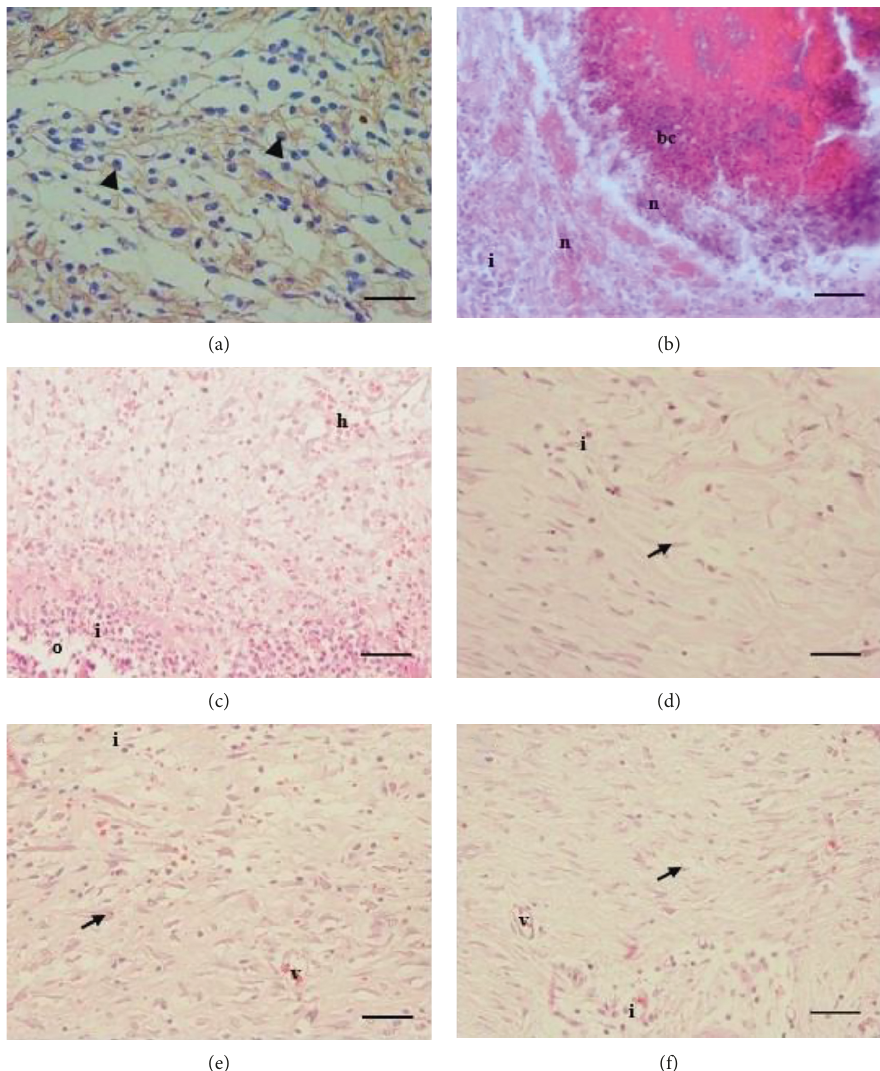
Figure 2: Photomicrographs of the dermal part of the skin wound healing. Predominantly expression of CD8+ on day 5 in treatment group (a); skin wound of control group on day 5 showed severe necrosis with bacterial colonization (b); dermis of group BC (c); group AV (d); group AC (e); and dermis of group SM on day 15 (f). Note: CD8+ expression (arrowhead); fibroblast (arrow); bacterial colonization (bc); haemorrhage (h); inflammatory cells infiltration (i); necrosis (n); edema (o); neovascularization (v). CD8+, DAB, 100x, scale bar: 50 µ m (a); H&E, 400x; scale bar: 50 µ m